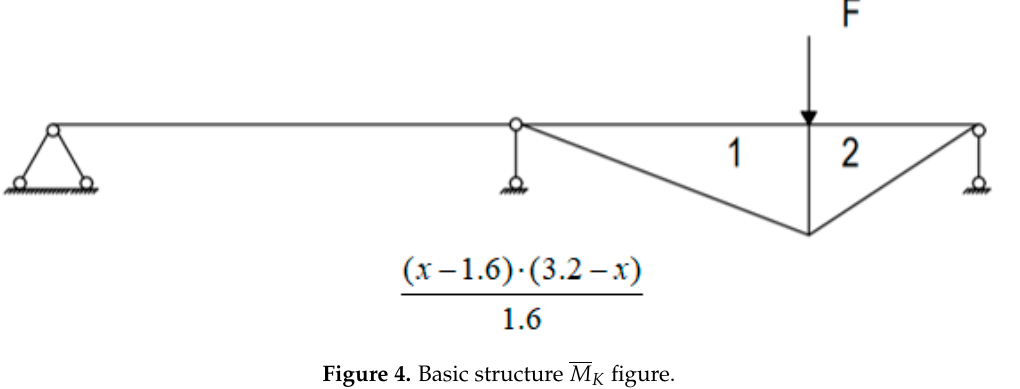
Figure 4. Basic structure M K